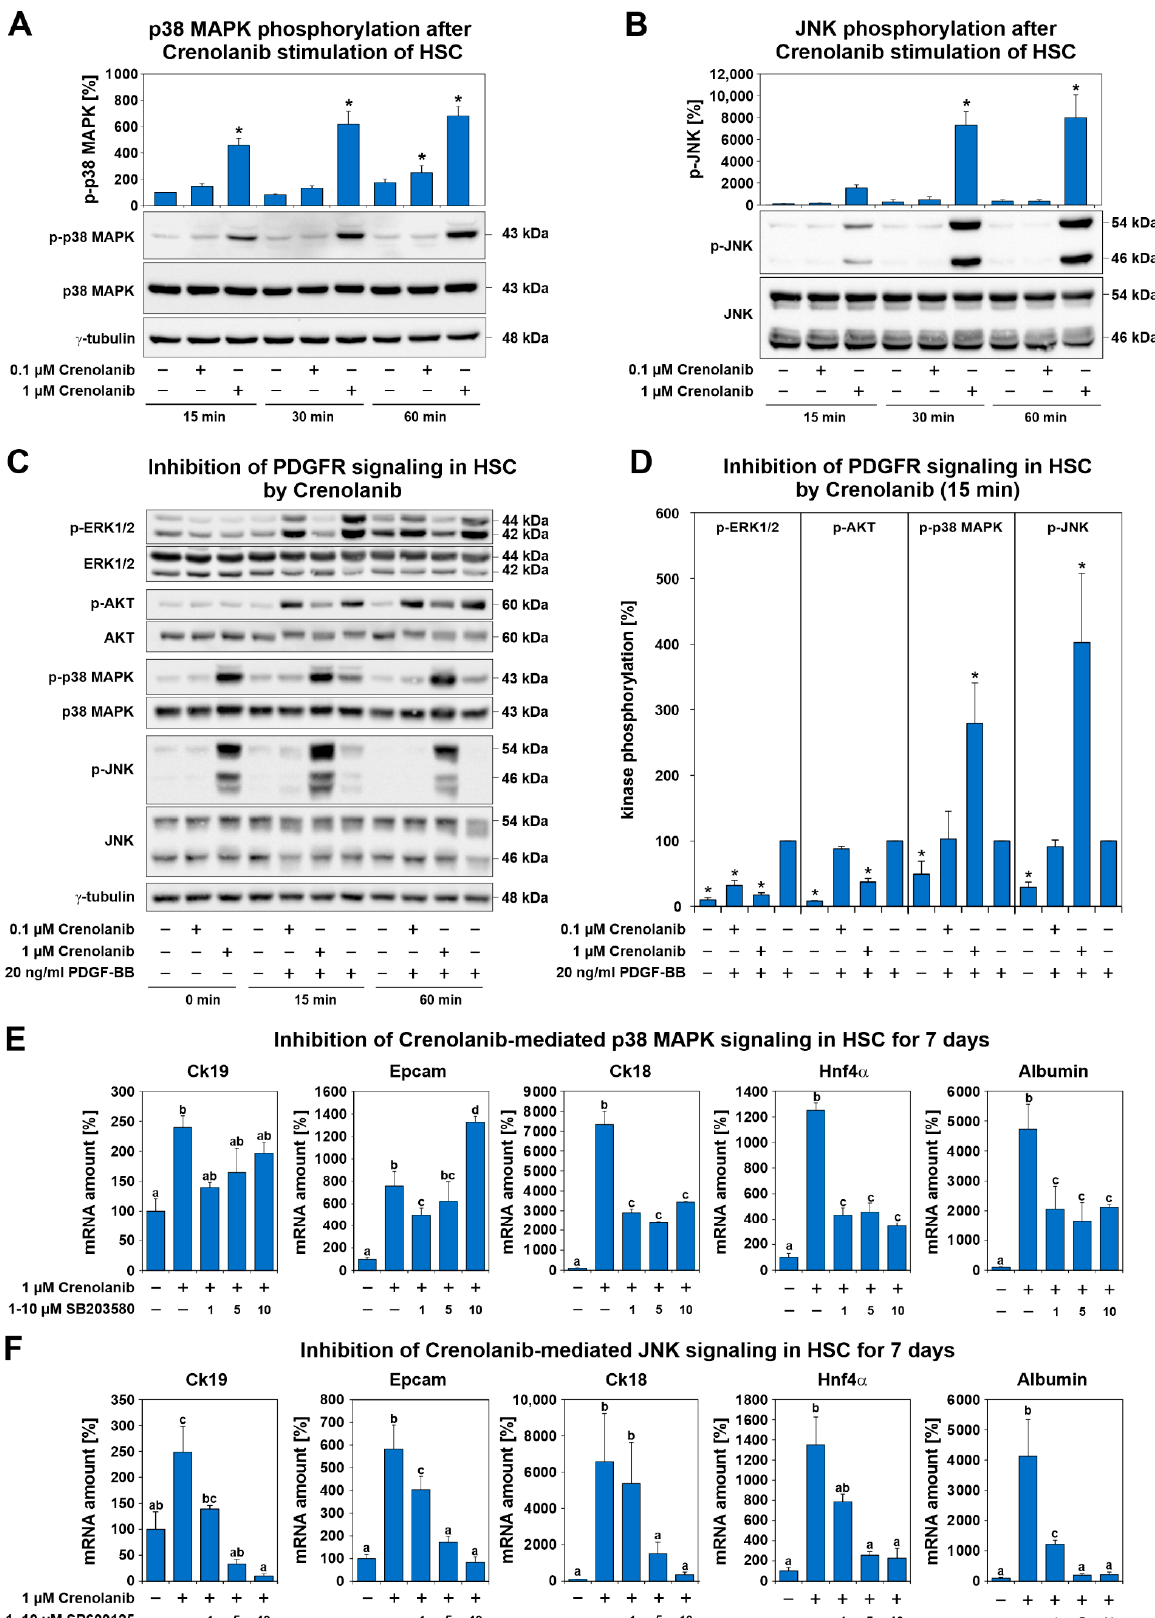
Figure 5. Crenolanib treatment enhanced p38 MAPK and c-Jun-activated kinase (JNK) activation in isolated rat HSC. ( A , B ) To identify the signaling pathways activated in HSC in the presence of Crenolanib, primary rat HSC were treated